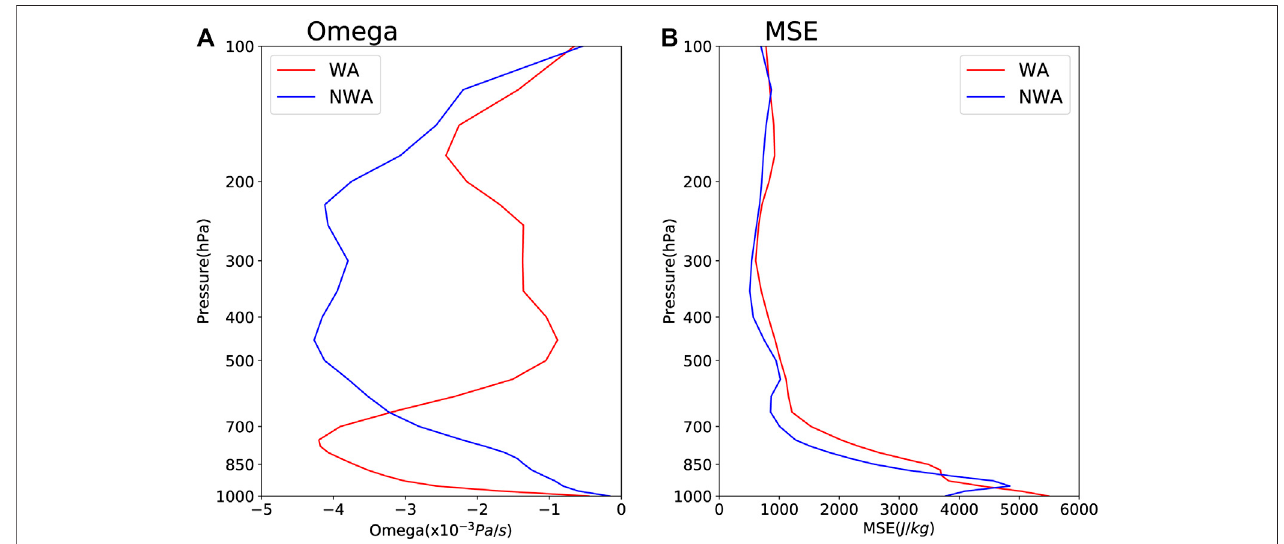
FIGURE 8 | Linear regressions of the vertical pro fi le of the austral summer (DJF) mean PC1 with (A) vertical velocity (10 − 3 Pa s − 1 ) and (B) MSE (J kg − 1 ) averaged over the NWA (blue line) and WA (red line) coastal regions during 1981 – 2018.